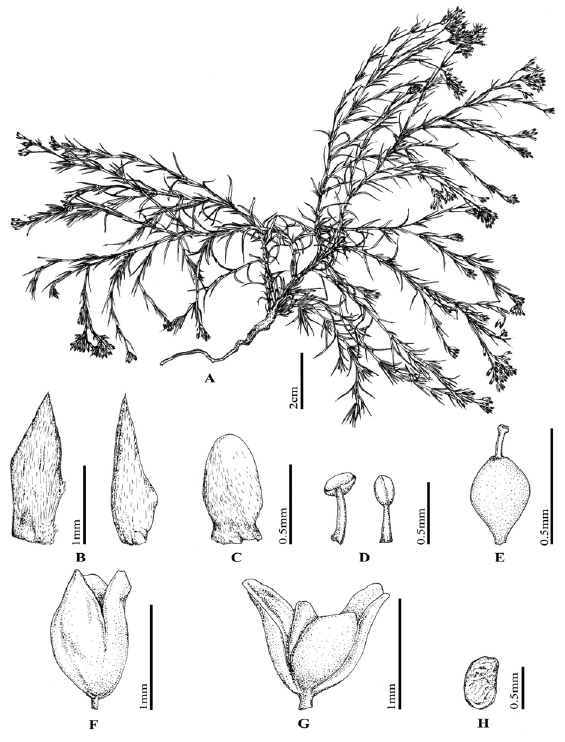
Figure 1. Polycarpaea aurea (Wight) Dunn (Caryophyllaceae) A - habit; B- sepals; C - petals; D - stamens; E - pistil; F - fruit; G - dehiscent fruit; H -